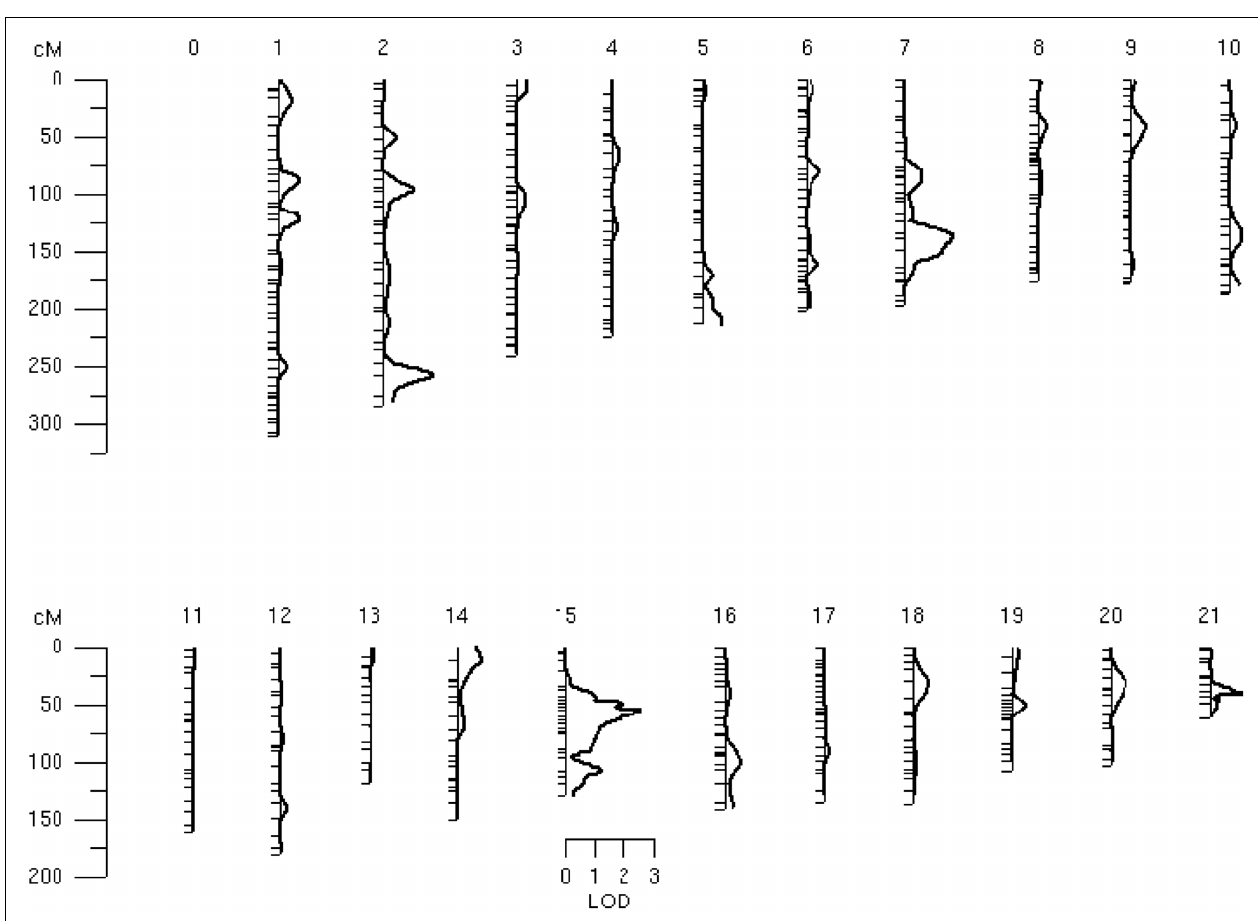
FIGURE 3 | Bivariate linkage analysis results for the GM thickness of the superior parietal lobule and FA values of the body of corpus callosum.